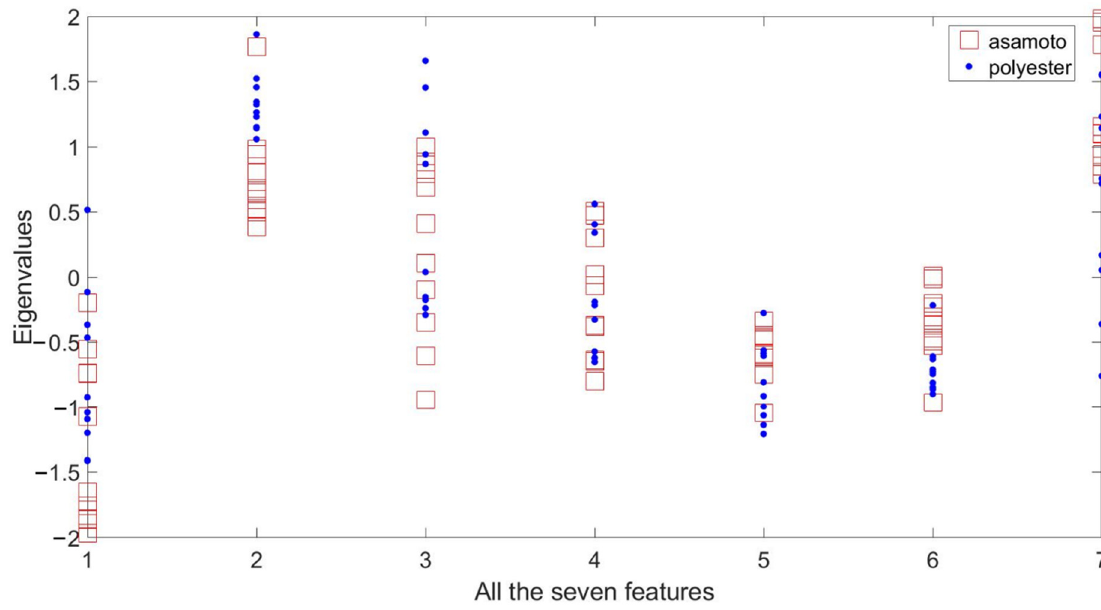
Figure 7. Features of asamoto and polyester.